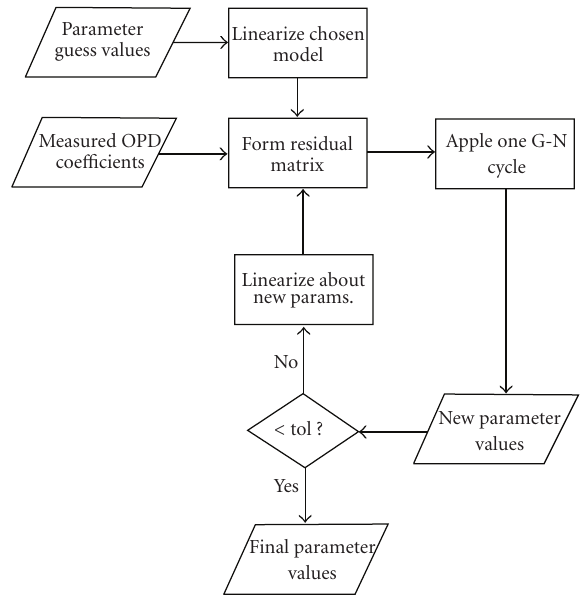
Figure 1: Flowchart for the multiresponse regression